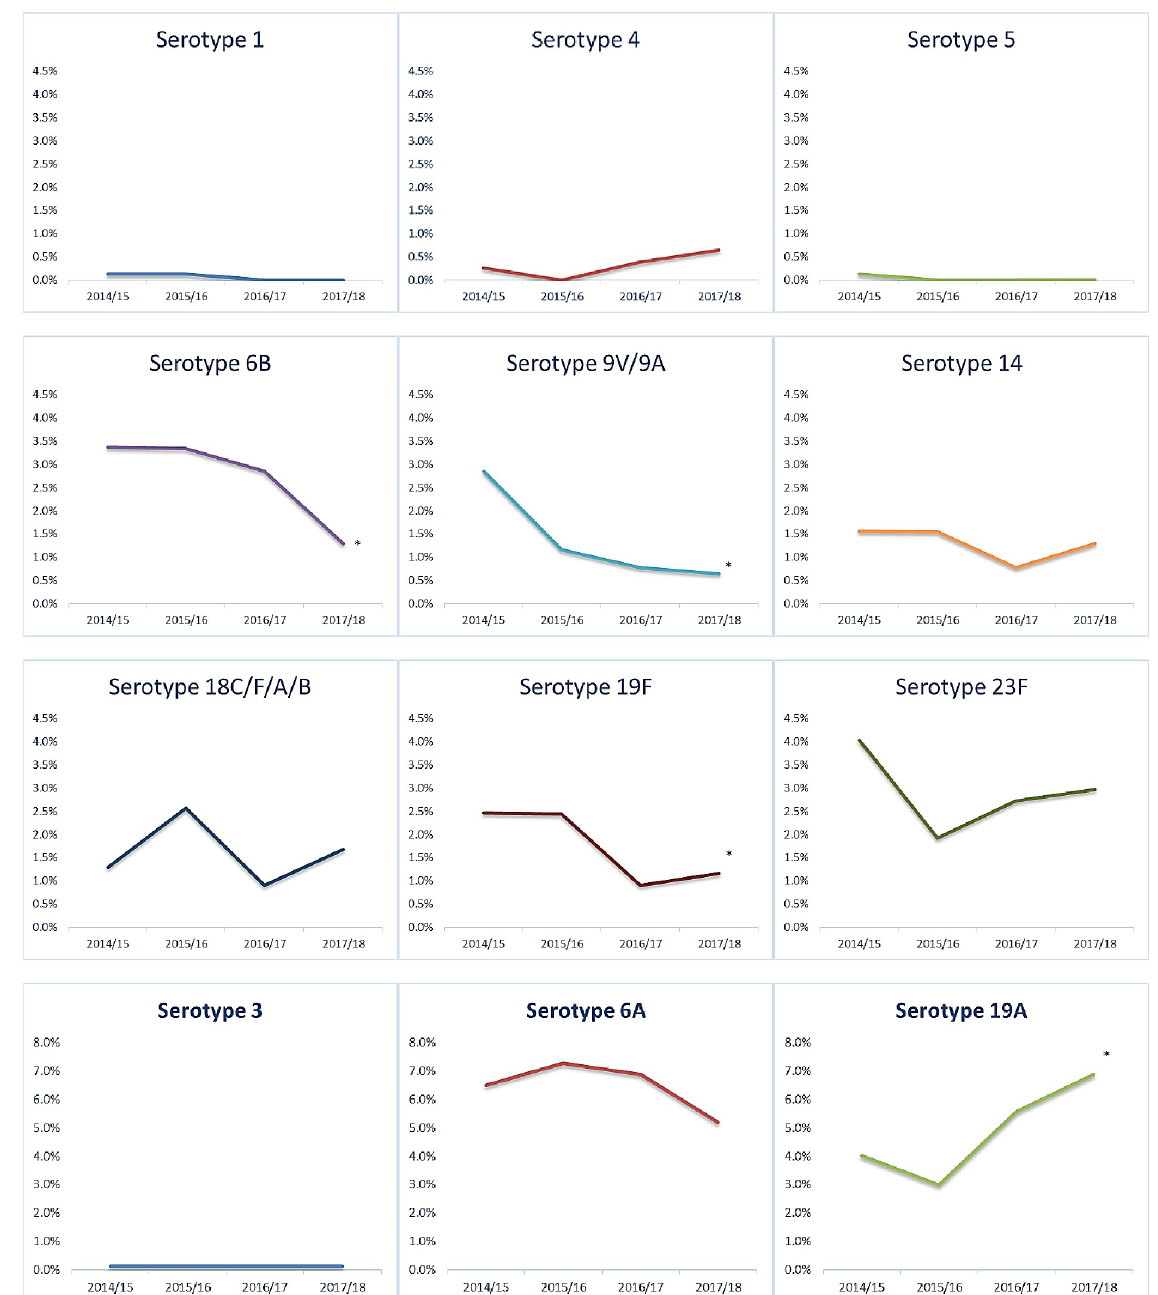
Fig 1. Individual serotype carriage rates over the study period. For 3 doses versus 0 dose-comparison, VE estimates for serotypes 9V/9A (VE = 65.0, 95% CI 26.0–83.5%), 19F (VE = 55.3, 95% CI 15.5–76.4%) and 6A (VE = 28.4, 95% CI 0.9–48.2%) reached statistical significance (Fig 2A). VE estimates for none of the serotypes reached statisti- cal significance when comparison was made for one or two PCV doses against no dose (Fig 2B and 2C).